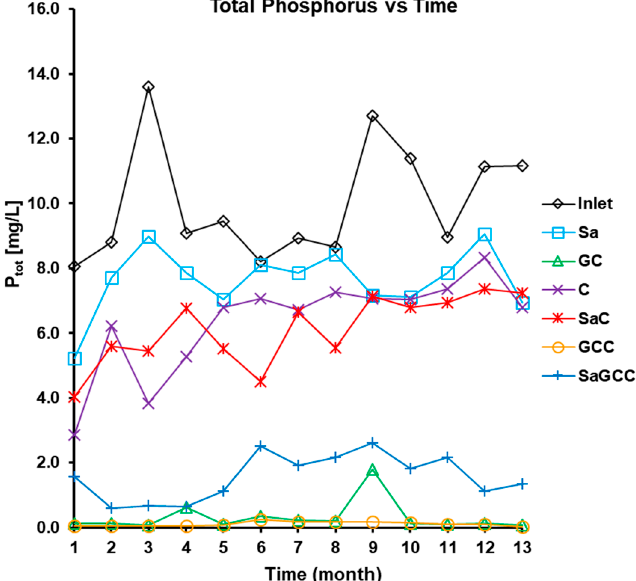
Figure 6. Total phosphorus trend during the entire study period (Sa, sand; GC, gas concrete; C, biochar; SaC, sand + biochar; GCC, gas concrete + biochar; SaGCC, sand + gas concrete + biochar).